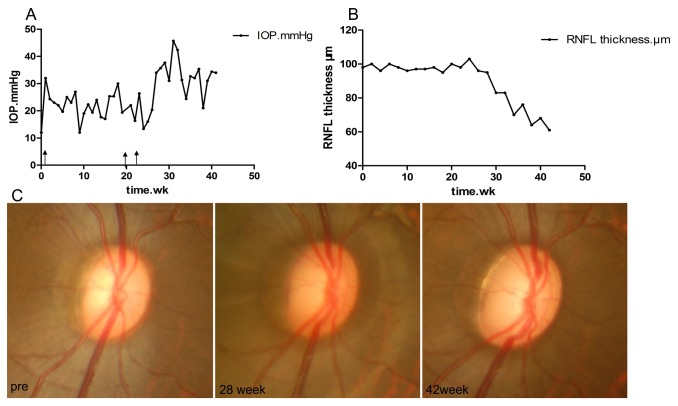
The chronic experimental glaucoma (exp gl) damage.A. The IOP elevation process after laser photocoagulation of the right eye of one monkey. The solid arrows indicate the laser treatments. B. The damage process to the RNFL thickness. Corresponding to the sustained elevated IOP in A, the RNFL thickness attenuated gradually after 28 weeks. C. Progressive optic disc cupping, corresponding to A.